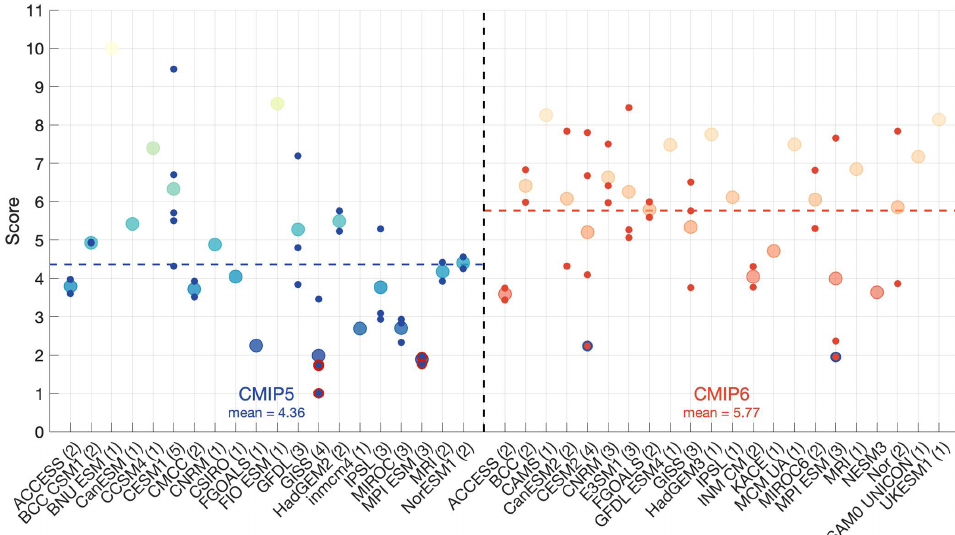
Figure 7. The scores for all CMIP5 and CMIP6 models. The large dots show the average score for all model groupings. Models are grouped by similar model physics and have in parentheses the number of models in the grouping after the name. Each model grouping has all model scores plotted as small blue (red) dots for CMIP5 (CMIP6) with the model average plotted in the larger dots. Models that have no like models are followed by a 1 in parentheses and only have a larger dot. The eight best scoring models (above the 90th percentile) are denoted with red outlines if they are among the CMIP5 suite of models – GISS E2 H CC, GISS E2 R CC, GISS E2 R, MPI ESM LR, MPI ESM MR, and MPI ESM P – or with blue outlines if they are among the CMIP6 suite of models – CESM FV2 and MPI ESM2 LR. Note that the overall scores for two of the GISS models and three of the MPI models in CMIP5 are almost exactly equal so outlines overlap almost